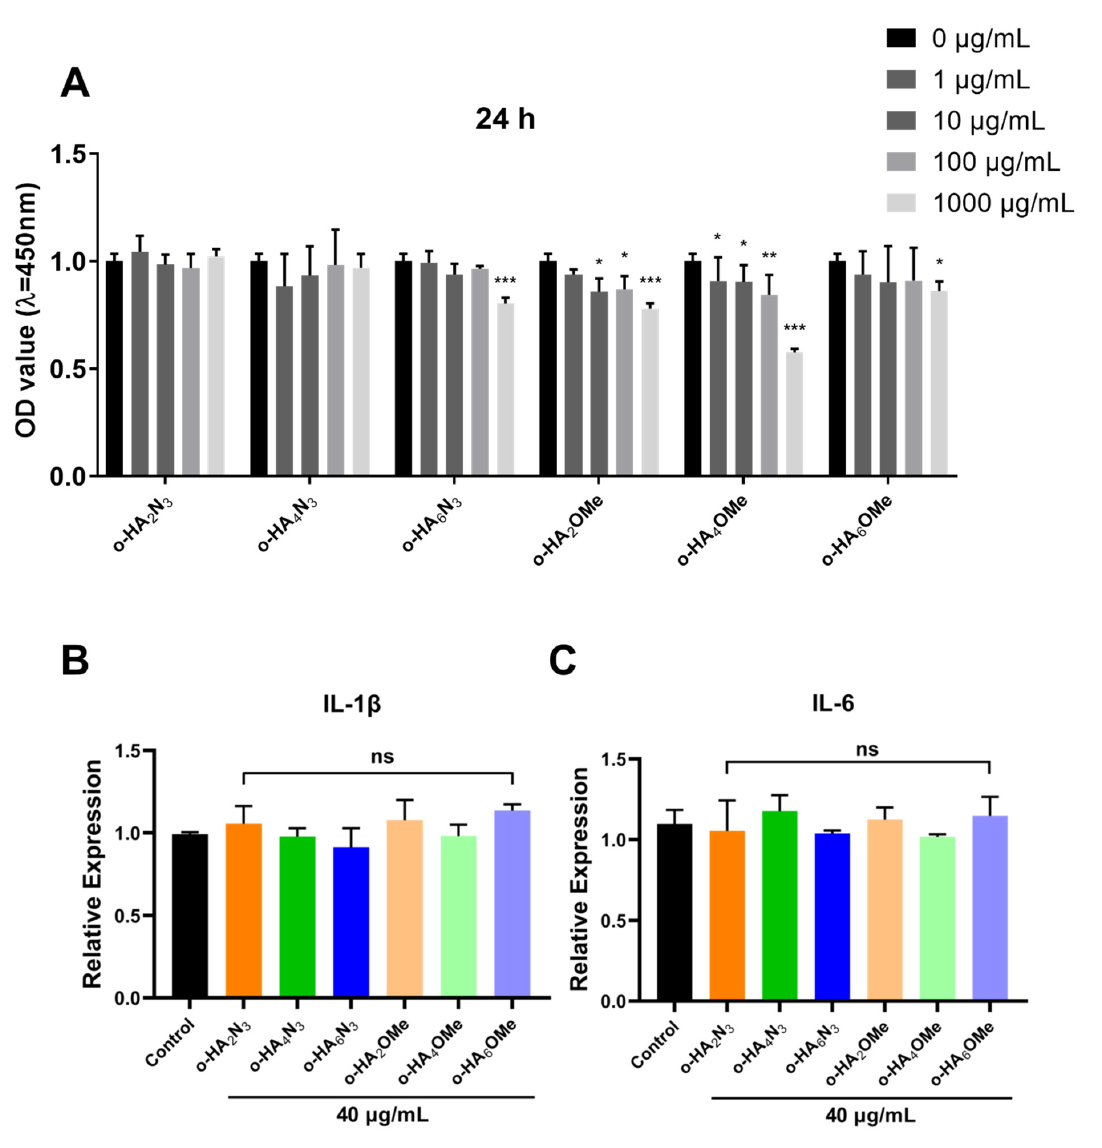
Figure 5. Evaluation of the cytotoxicity and pro-inflammation of o-HAs derivatives in ATDC5 cells. ( A ) ATDC5 cells were seeded into 96-well plates. After 12 h of incubation, cells were treated with different concentrations (0, 1, 10, 100, 1000 μ g/mL) of different o-HAs derivatives for 24 h. Next, cell viability was examined by the CCK-8 assay. ( B , C ) RT-qPCR was used to confirm the expression levels of pro-inflammatory cytokines (IL-1 β , IL-6) after co-culture with ATDC5 cell of different o-HAs derivatives (40 μ g/mL) for 24h. * p < 0.05, ** p < 0.01, *** p < 0.001 vs. each 0 μ g/mL group; ns = not statistically significant vs Control group.